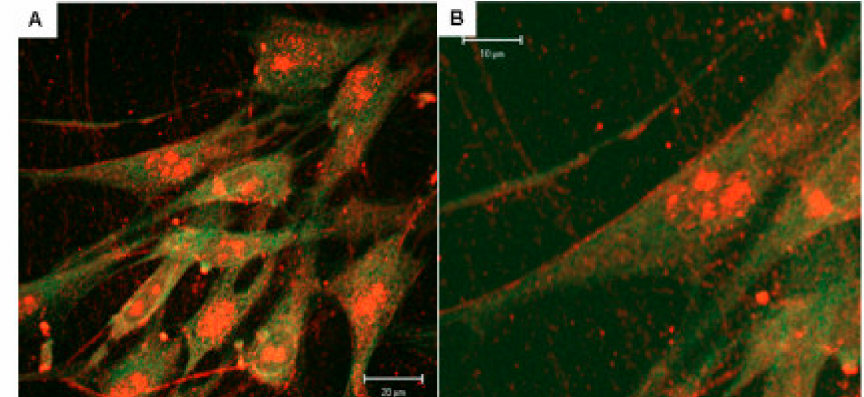
Figure 3. Fluorescent immunostaining of ARSB in human cerebrovascular cells. ( A , B ). Confocal microscopy demonstrates cell surface localization of ARSB in untreated cerebrovascular cells, as well as cytoplasmic and nuclear localization and presence of ARSB in cell projections. ARSB is stained red, and β -actin is stained green